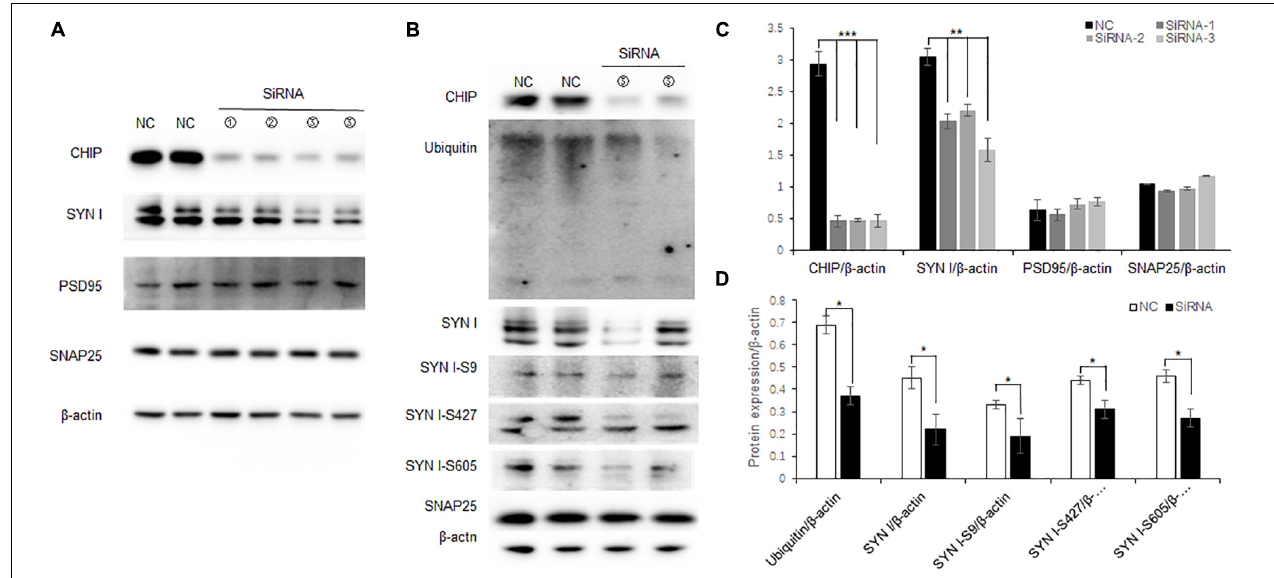
FIGURE 6 | Decreased CHIP expression altered synaptic protein expression and phosphorylation in N2a cells. (A) CHIP knock-down protein was designed by siRNA in N2a cells. Approximately 5 µ l Stub1-siRNA was able to achieve effective knock-down CHIP expression, and consequently the expression level of synapsin I S9 was decreased with no change in synaptic protein SNAP25 and PSD95 expression. (B) Statistical bar chart to show that CHIP, synapsin I, SNAP25, and PSD95 expression were present ( n = 6, ** p < 0.01, *** p < 0.001). (C) The dose of 5 µ l Stub1-siRNA showed a decrease in the expression levels of ubiquitin and synapsin I and the phosphorylation levels of synapsin I S9, S427, and S605. (D) Statistical bar chart to show that ubiquitin, synapsin I, synapsin I S9, S427, and S605 expression were present ( n = 6, * p < 0.05).